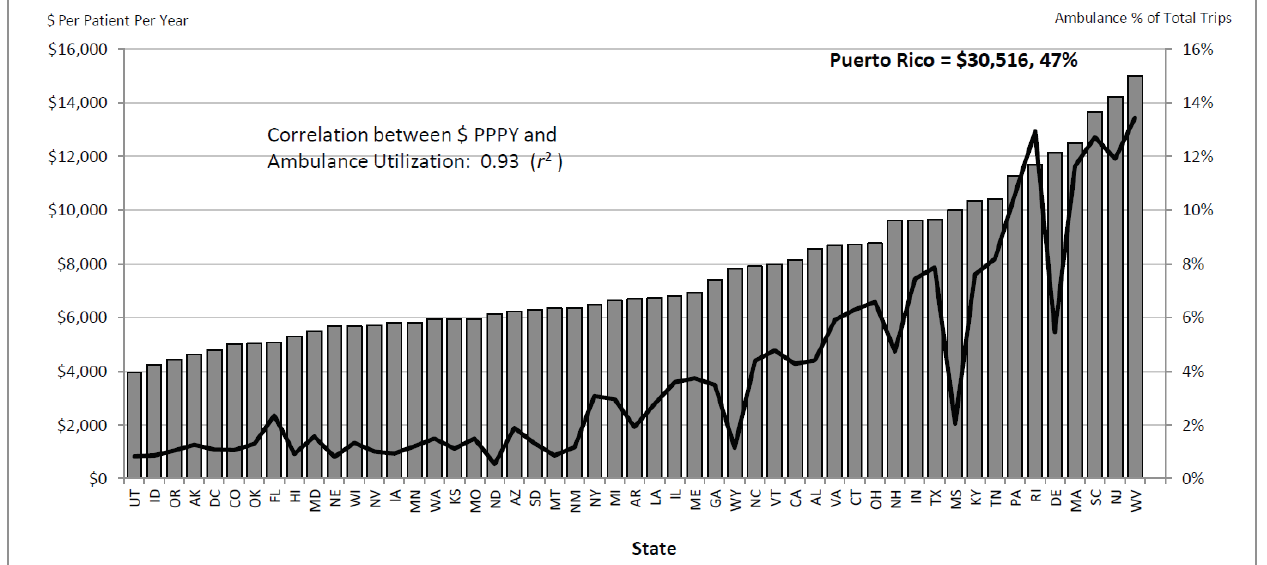
The correlation was calculated from state-level observations, using the percent of total trips that were via ambulance correlated with total costs PPPY.